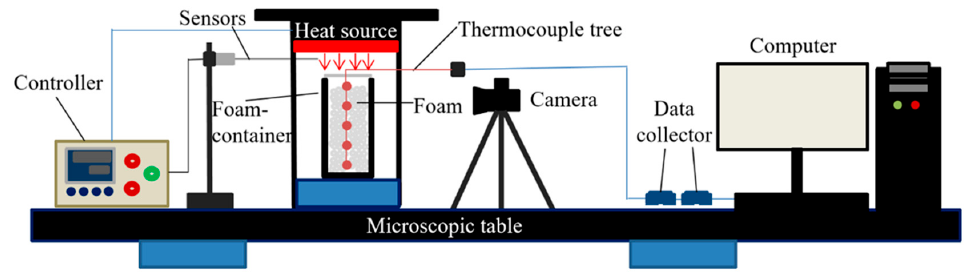
Figure 10. Experimental device for foam thermal stability. During the experiment, the radiant heat source was turned on to preheat to the specified temperature, and five K-type armored thermocouples were arranged in the square tube at intervals of 3 cm in depth. Their position from top to bottom were K5, K4, K3, K2, and K1. The distance between K5 and the lower surface of heat source was 3 cm. A total of 90 mL of foam was added to the square tube and placed under thermal radiation; the temperature data were collected with a computer, and the volume change of foam was recorded with a camera. The foams were prepared by double-syringe foaming technology; the specific operation steps can be seen in Ref. [5]. The foams were generated with the same initial volume for different dispersions based on this method. The bubble distributions are highly reproducible [47]. For each experiment, the volumes of liquid and gas used to generate foam were 30 and 60 mL, respectively.